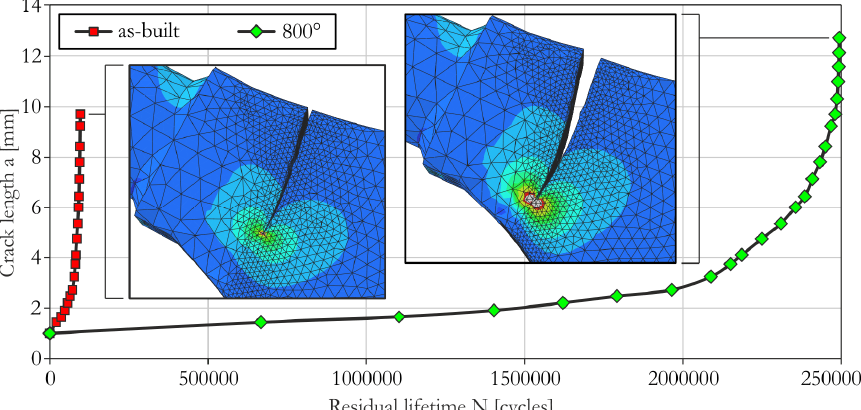
Figure 7: Numerical crack growth simulation depending on the material